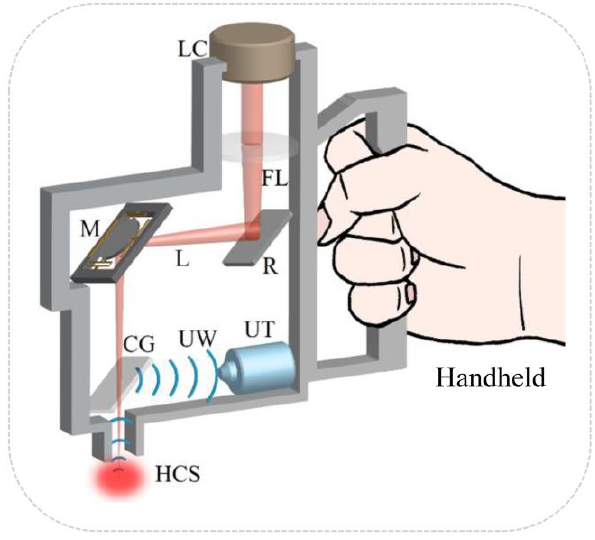
Figure 2. The portable OR-PAM system. LC, laser collimator; FL, focus lens; R, reflector; L, laser; M, micromirror; CG, cover glass; UW, ultrasonic wave; UT, ultrasonic transducer; HCS, highly converging spot.